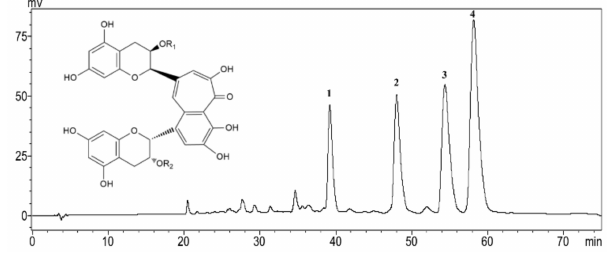
Figure 1. HPLC chromatogram of theaflavins (TFs). 1, Theaflavin (TF): R 1 =R 2 =H; 2, Theaflavin-3-gallate (TF-3-G): R 1 =H, R 2 =galloyl; 3, Theaflavin-3 (cid:48) -gallate (TF-3 (cid:48) -G): R 1 =galloyl, R 2 =H; 4. Theaflavins-3, 3 (cid:48) -digallate (TFDG): R 1 =R 2